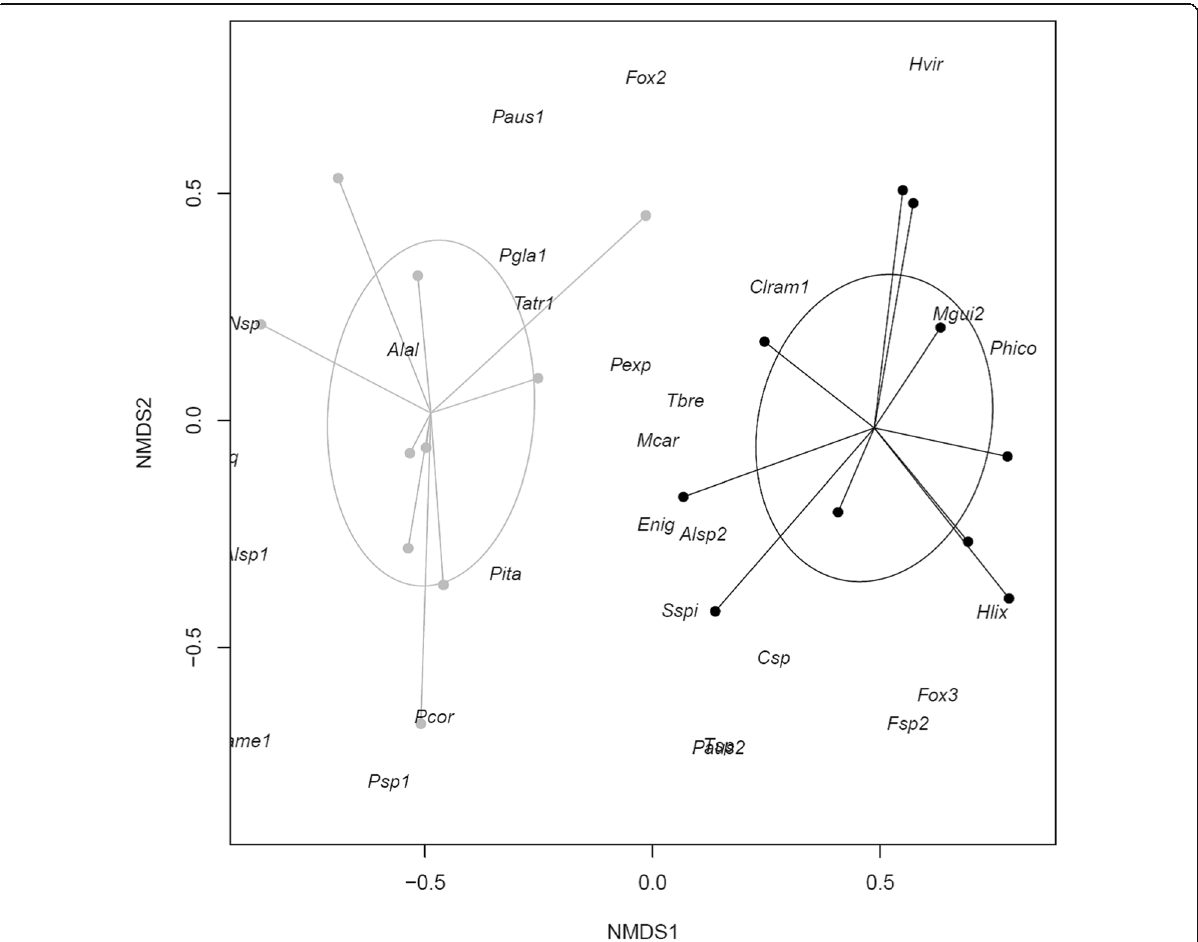
Fig. 3 Non-metric multidimensional scaling ordinations for fungal endophyte communities associated with Aristolochia chilensis as a function of above- (gray lines) and below ground (black lines) tissues. Arrows show significant indicator species associated with leaf and root tissues (Alal: Alternaria alternata ; Alsp1: Alternaria sp.1 ; Alsp2: Alternaria sp.2; Clram1: Cladosporium ramotenellum1; Csp: Clonostachys sp.; Enig: Epicoccum nigrum; Fox2: Fusarium oxysporum2 ; Fox3: Fusarium oxysporum; Fsp2: Fungal sp.2 ; Hlix: Hypocrea lixii; Hvir: Hypocrea viridiscens ; Mcar: Meyerozyma caribbica; Mgui2: Meyerozyma guilliermondii2; Nsp: Neostagonospora sp.; Pcor: Penicillium corylophilum; Pexp: Penicillium expansum ; Pgla1: Penicillium glabrum1; Pita: Penicillium italicum; Phico: Phialemoniopsis cornearis; Paus1: Preussia australis1; Paus2: Preussia australis2; Psp1: Penicillium sp.1 ; Sspi: Sarocladium spinificis; Tatr1: Trichoderma atroviride1 ; Tbre: Trichoderma breve ; Tsp: Trichoderma sp.